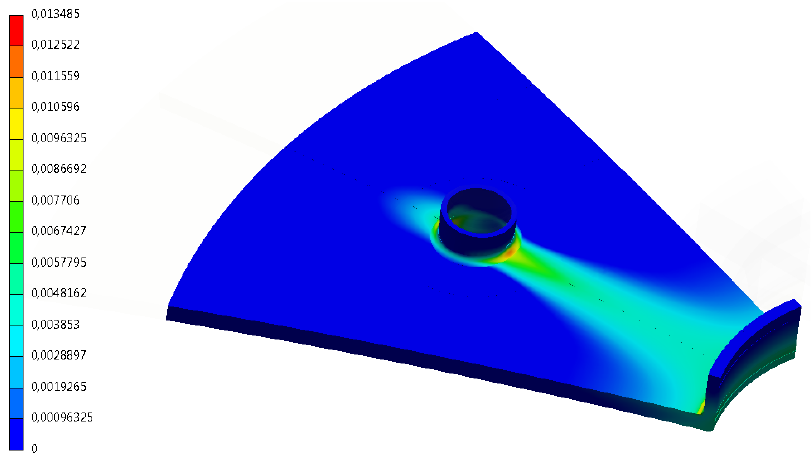
Figure 5. Plastic deformation zone in the pressure vessel, located between the stub pipe and the manhole [mm/mm].